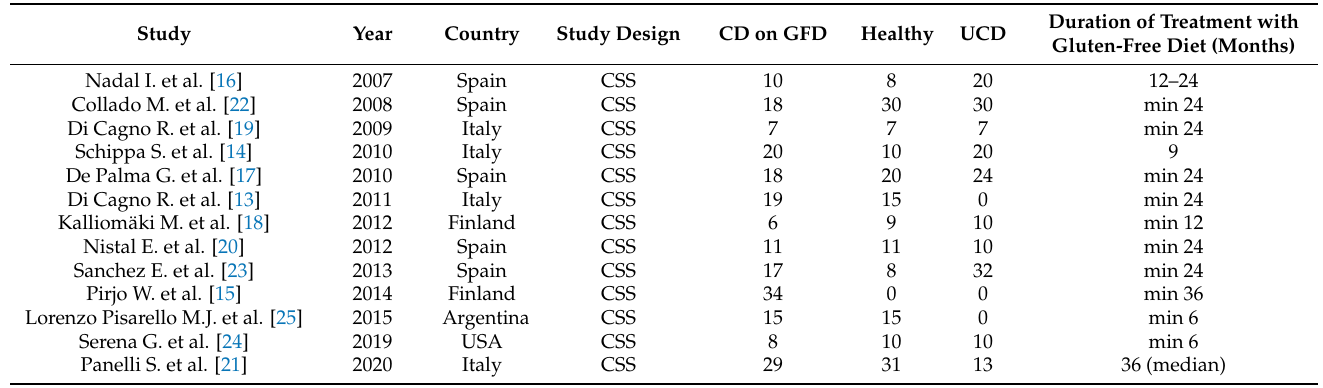
Table 1. Characteristics of the included studies ( n =